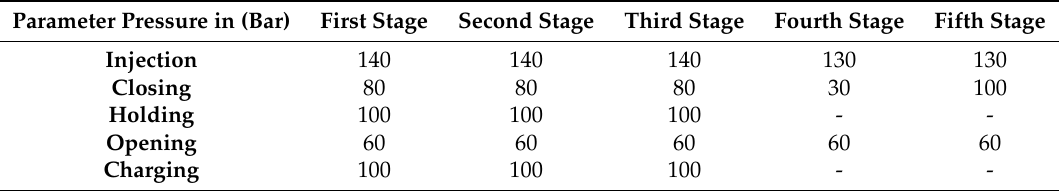
Table 2. Conditions of the injection molding machine.